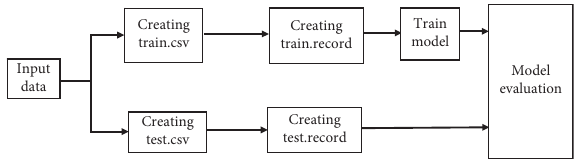
Figure 5: Detailed of the labeling model.